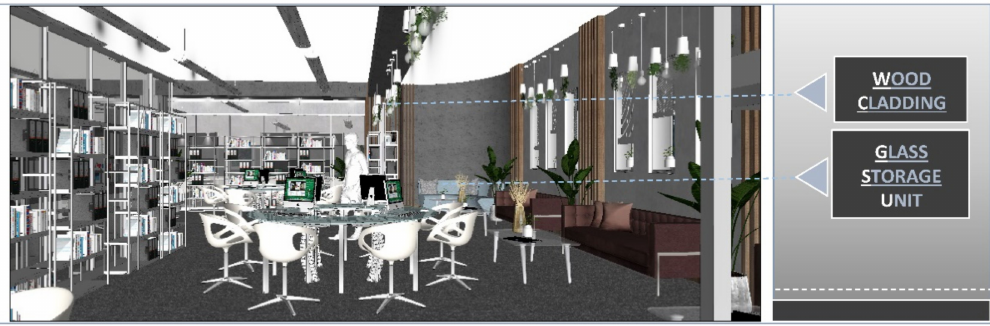
Figure 20. Storage units for books.